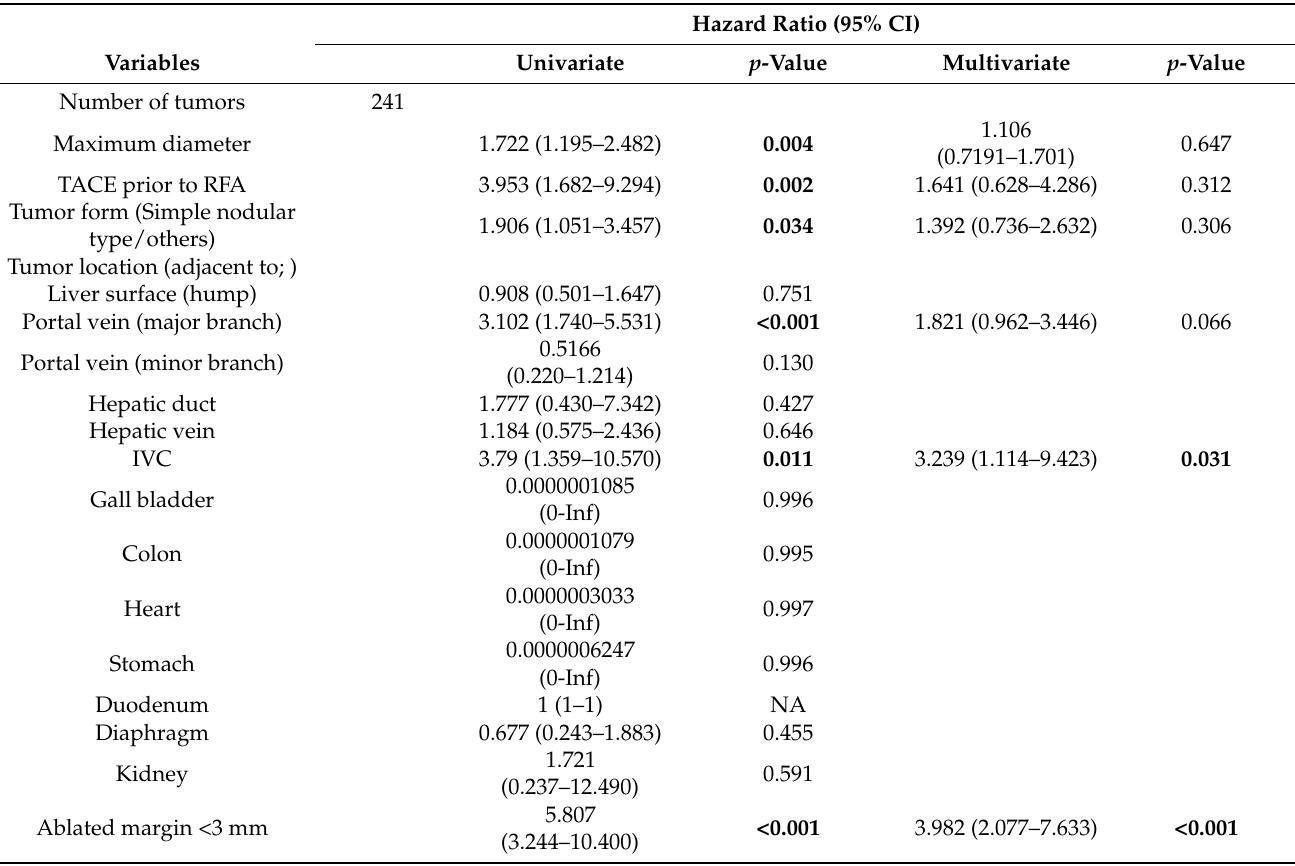
Table 4. Predisposing factors for local tumor progression after